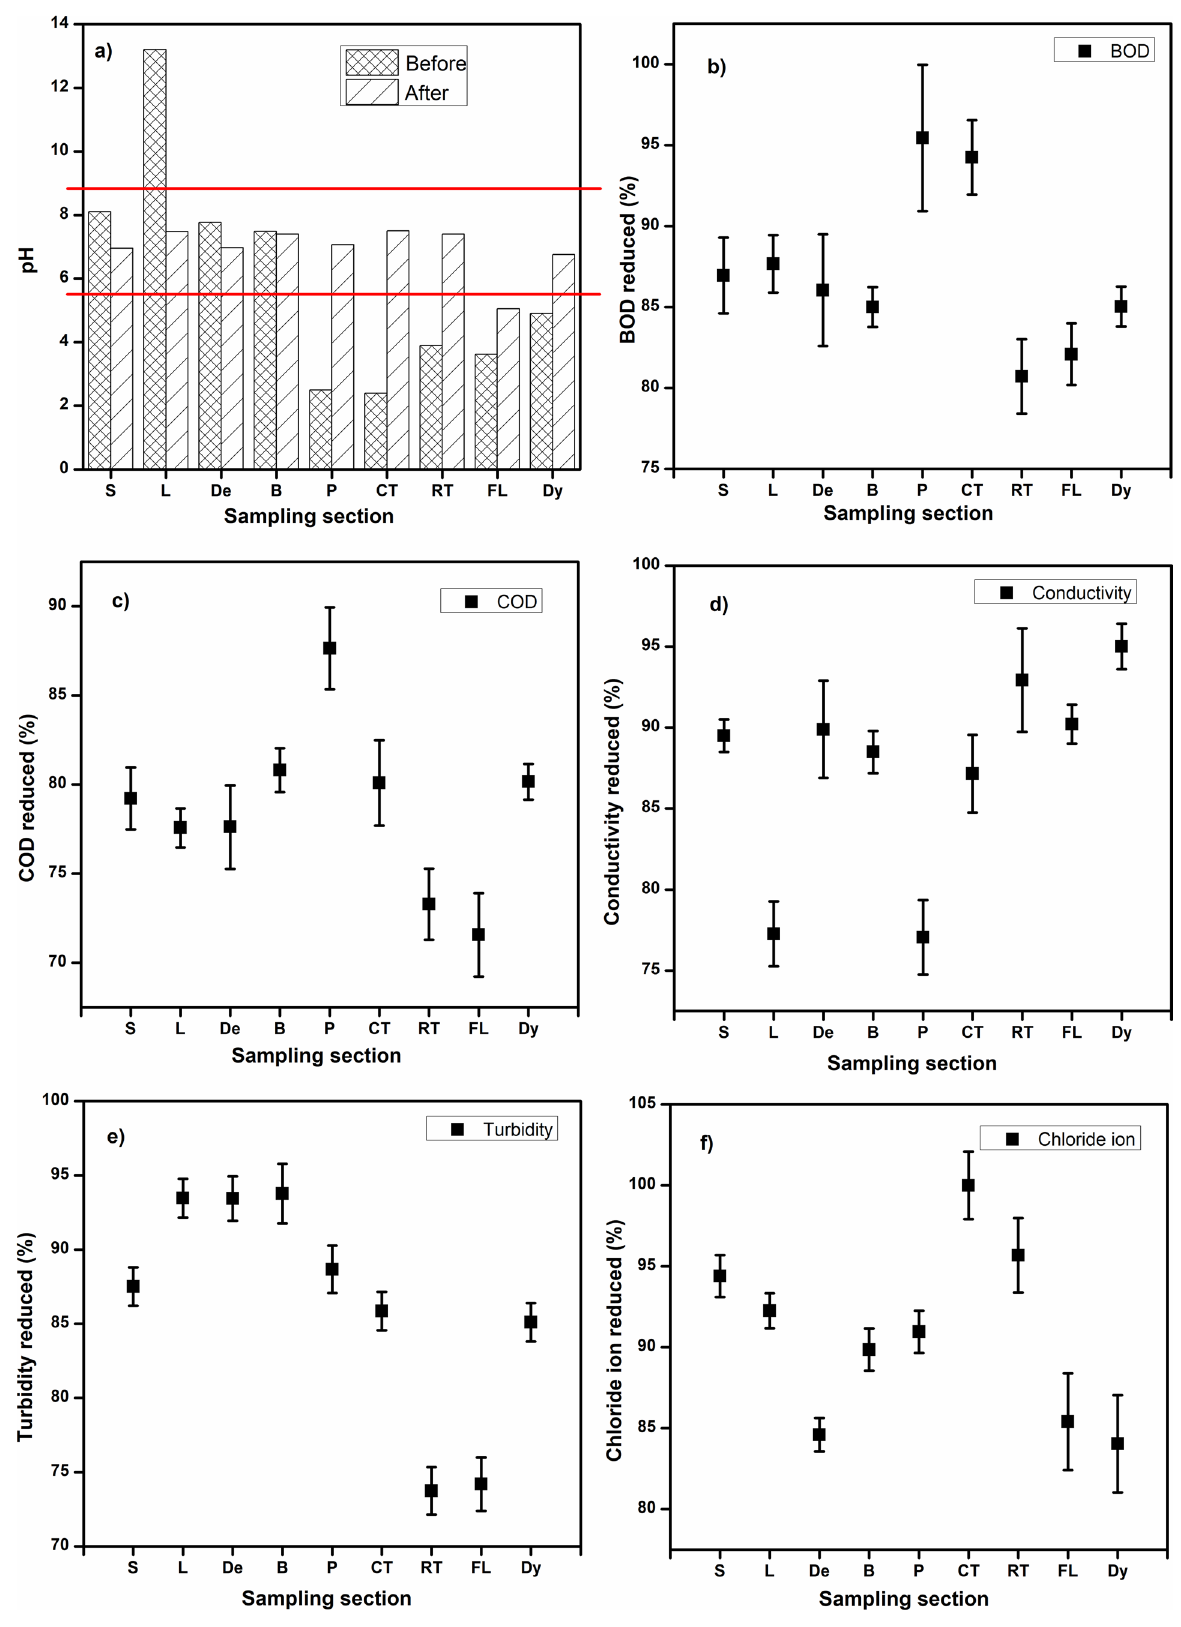
Fig. 6 Decrease of physical parameters of waste-water by AC: ( a ) pH, ( b ) BOD, ( c ) COD, ( d ) conductivity, ( e ) turbidity, ( f ) chlorine